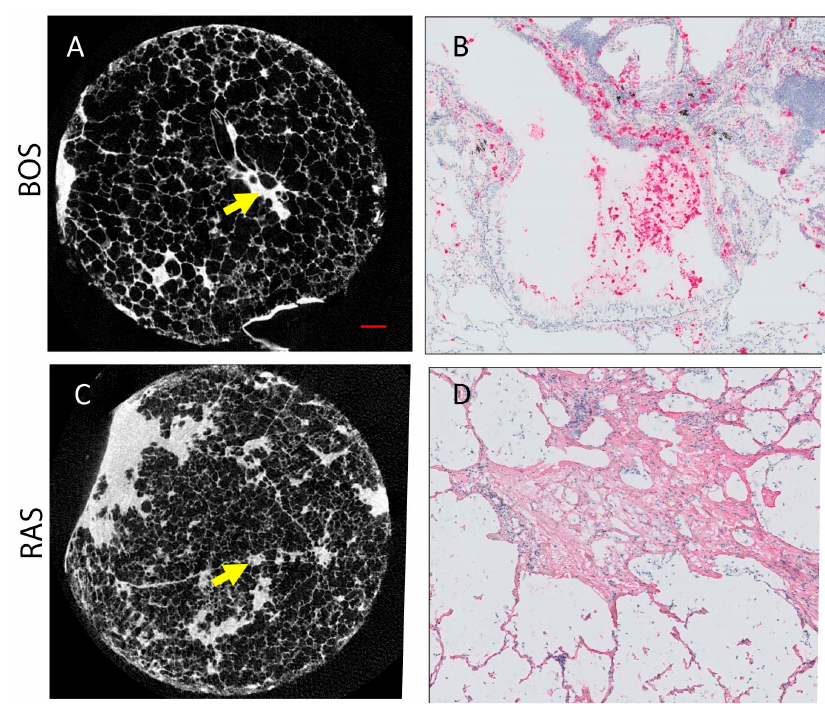
Figure 5. Representative microCT and immunohistochemistry for BOS (( A , B ), respectively) and RAS (( C , D ), respectively) cases. ( A ) MicroCT image of BOS core where normal airway parenchyma is seen. The arrow indicates an obliterated airway. ( B ) Neutrophil staining (pink) corresponds to the site of the arrow on ( A ). ( C ) MicroCT image of RAS core where some patchy fibroblast foci can be seen. ( D ) Collagen I stain (pink) is shown at the site of the arrow on ( C ). Scale bar (red line in ( A )) represents 1 mm on both microCT ( A , C ). ( B , C ) were counter stained with hematoxylin (blue). Table 3. Structural and Biological Measures from Core Samples.